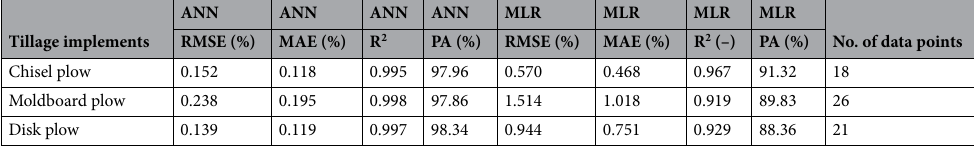
Table 4. Comparison between the calculated performance criteria for ANN and MLR models for prediction of tractor rear wheel slip during plowing process using testing dataset.